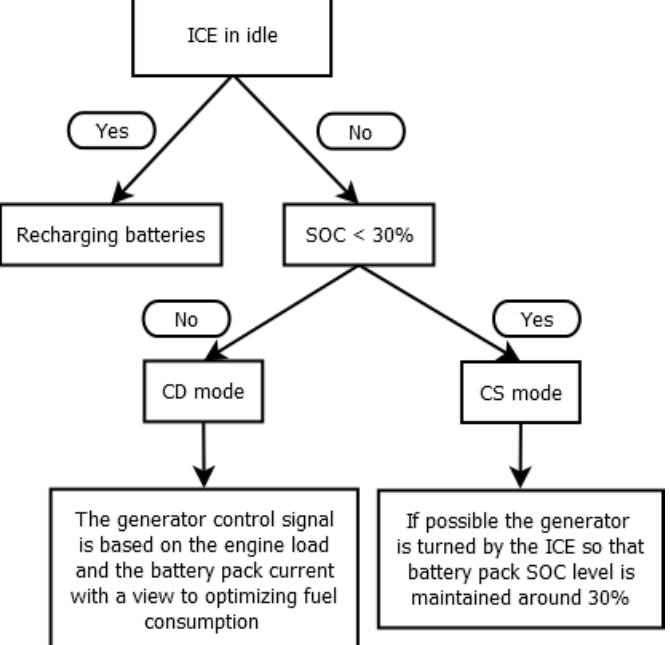
Figure 7. Energy management strategy for HeCVT